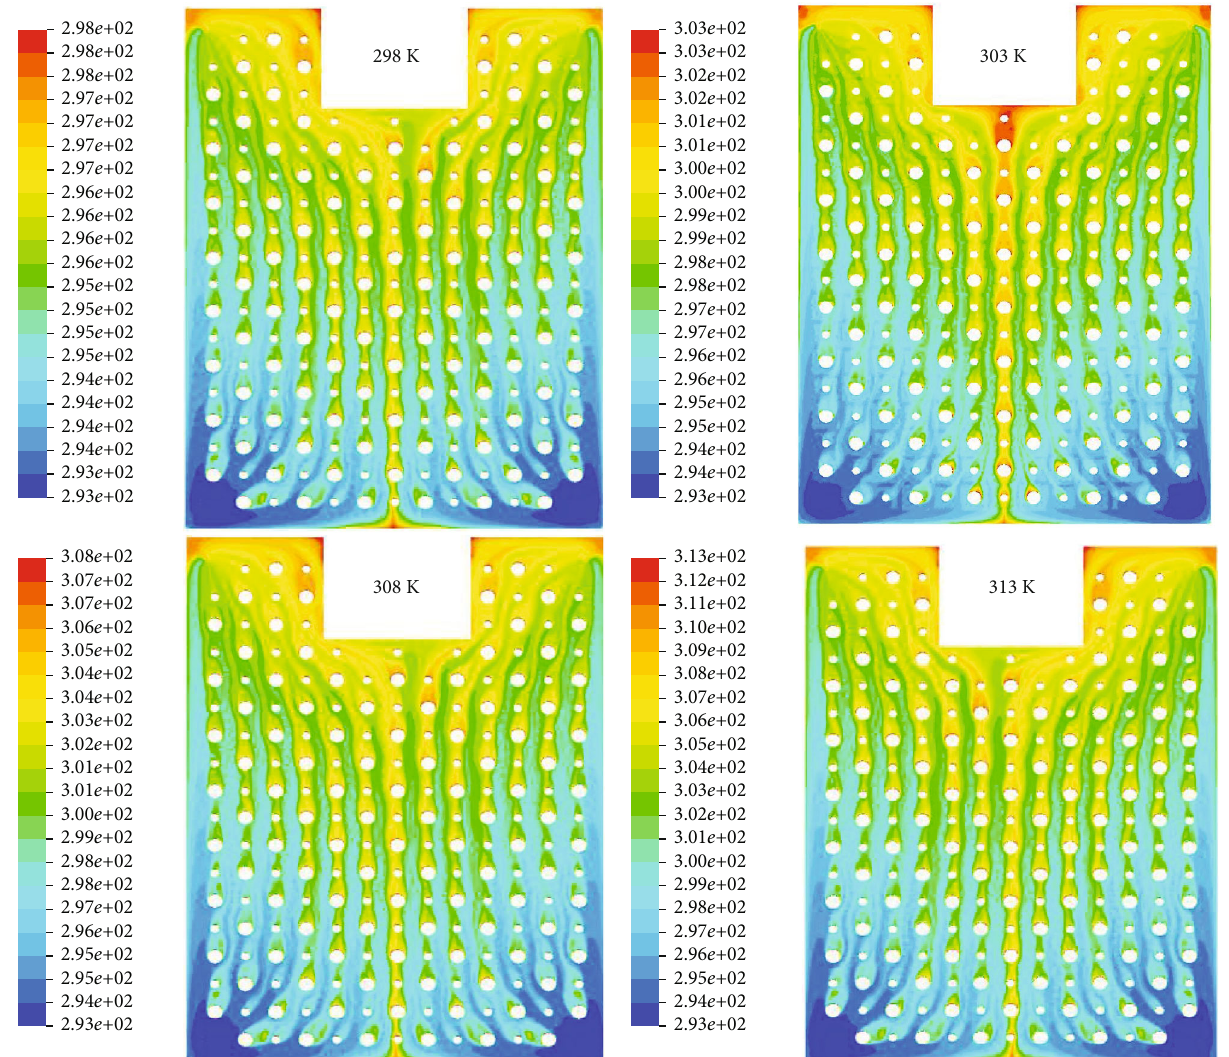
Figure 7: Temperature distribution of water (in K) at di ff erent heating surface